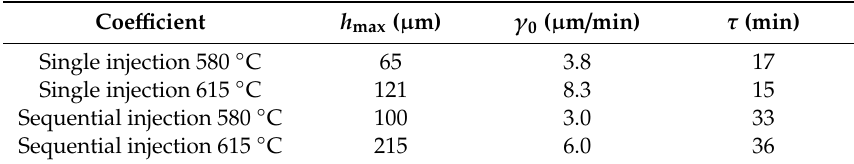
Table 2. Fitted parameters γ 0 (initial growth rate), τ (catalyst lifetime) and corresponding h max with the exponential